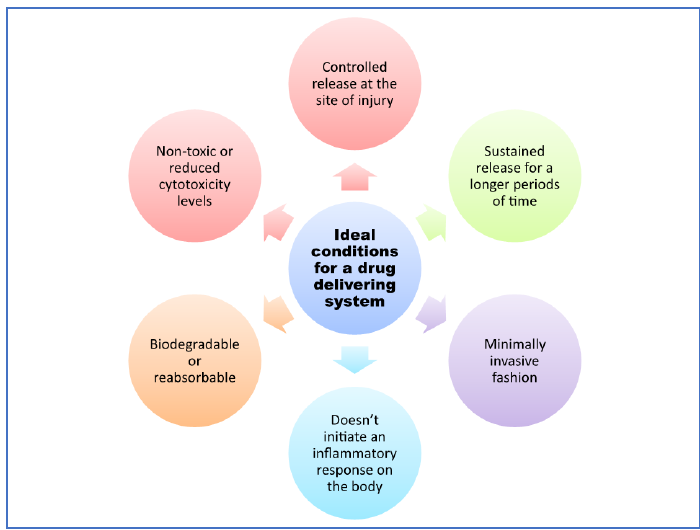
Figure 2. Ideal properties of drug delivery system.